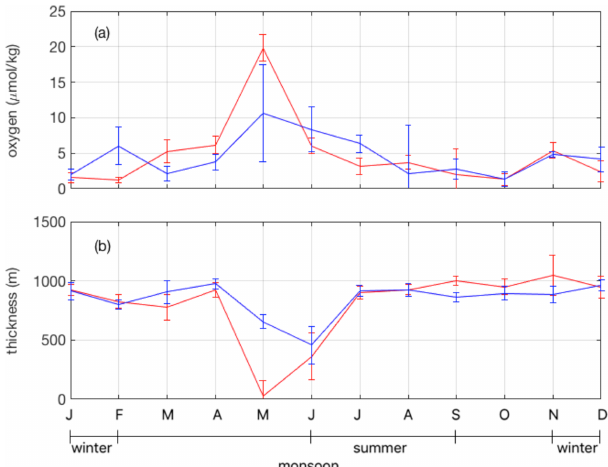
Figure 3. (a) Mean seasonal cycle of dissolved oxygen concentra- tion on the isopycnal surface of σ = 27kgm − 3 at the location of the ER (red) and the WR point (blue) from observations. (b) Mean seasonal cycle of the thickness of the layer containing less than 10µmolkg − 1 of oxygen based on WOA13 at the location of the ER (red) and the WR point (blue). The error bars show the spatial standard deviation in an area of 2 ◦ × 2 ◦ centred around the release